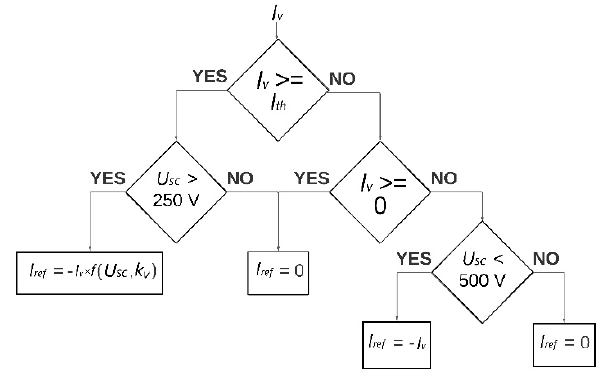
Figure 4. Flow diagram for the high kinetic energy zone.